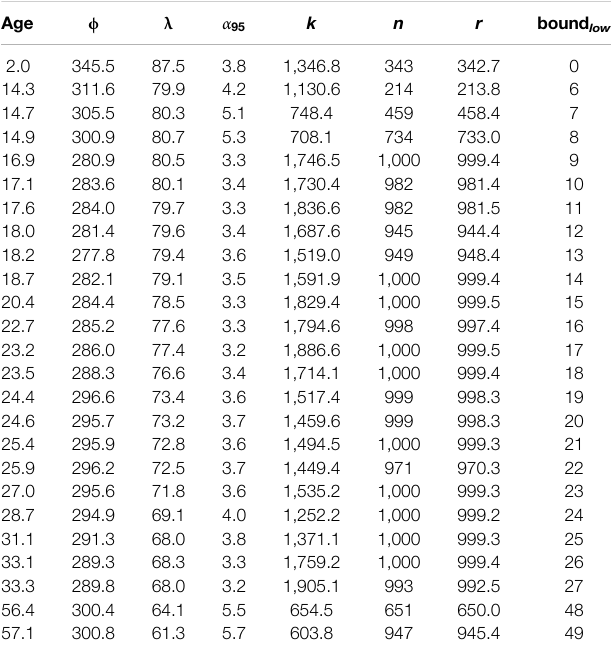
TABLE 2 | Summary Poles (Vandamme (1994) fi ltered) for 10 Ma search intervals (in degrees N and E). Median age assigned to pole (in Ma), λ indicates pole latitude, ϕ indicates pole longitude, with in degrees, k : precision parameter, n : number of valid bootstrap samples (out of 1,000), r : resultant, and indicates low age bound of search window. For bootstrap samples, un fi ltered poles and hotspot paleolatitudes interpolated with spline fi ts see Supplementary Material .